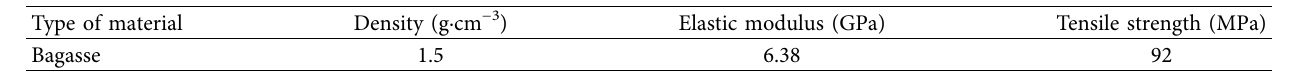
Table 3: Comparison of mechanical properties between bagasse and other fibrous